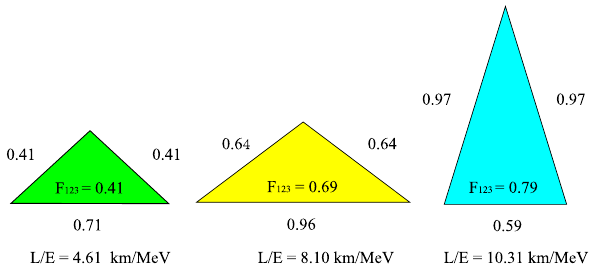
Fig. 3 The lengths of the edges and the areas for the concurrence triangles with L / E = 4 . 61 km / MeV, L / E = 8 . 10 km / MeV, and L / E = 10 . 31 km / MeV, respectively, are shown in the three-flavored electron NOs